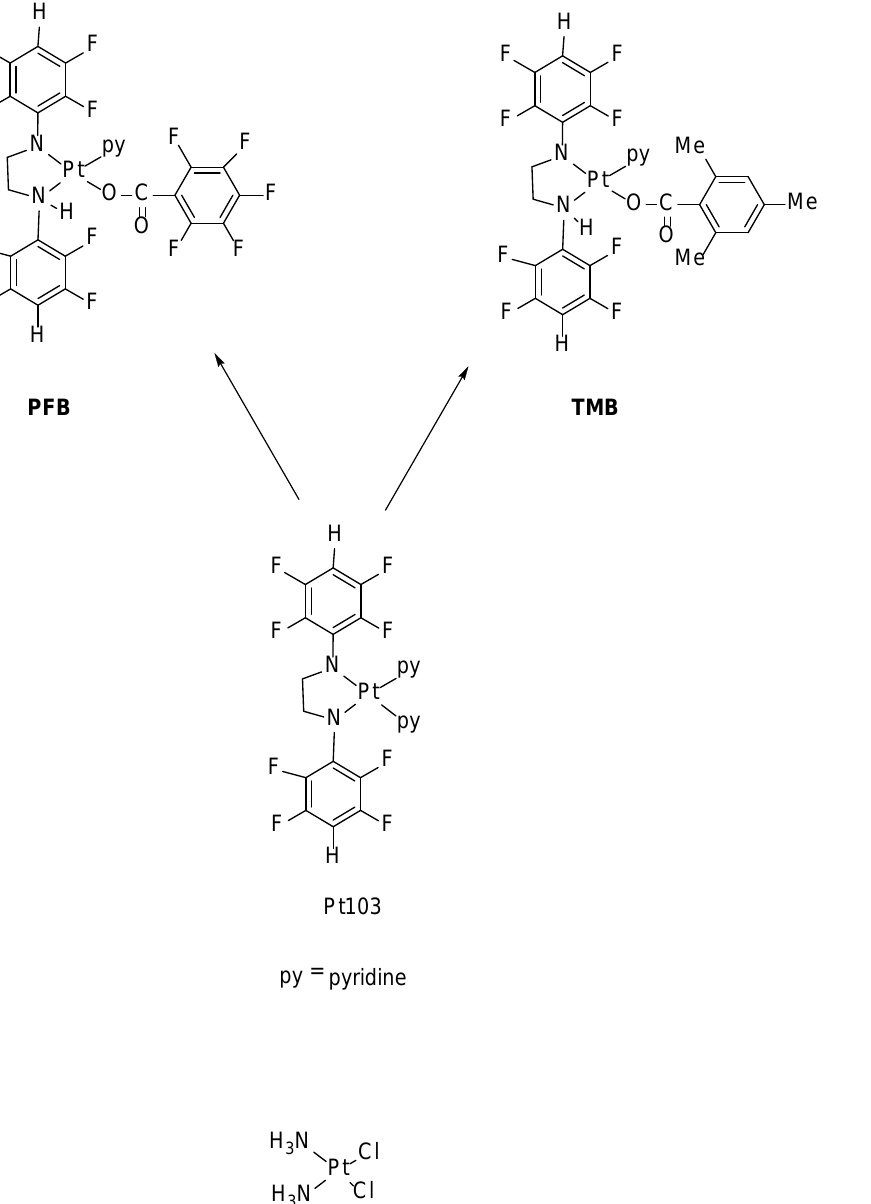
Figure 1. Chemical structures of PFB , TMB and cisplatin.